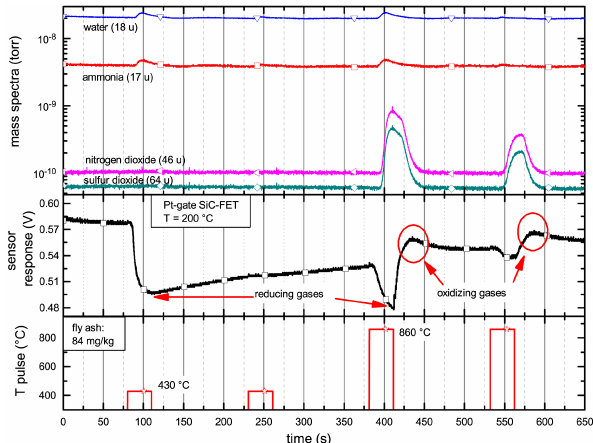
Figure 8. Top: mass spectra; middle: sensor response of a Pt-gate SiC-FET at 200 ◦ C; bottom: heating pulses to 430 and 860 ◦ C of ammonia-contaminated fly ash (84mgkg − 1 ). With PermaPure tube for humidifying the carrier gas (synthetic